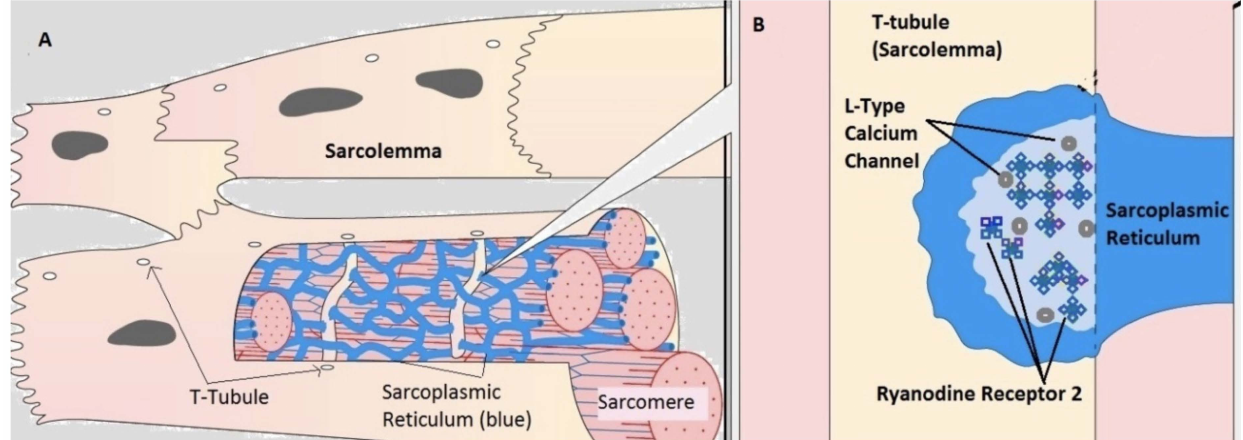
Figure 1. Cardiac myocyte structure. In the cardiac myocyte ( A ), CICR occurs at a specialized sub-domain called a dyad ( B ). The array of L-type calcium channels (LCC) on the T-tubule membrane and ryanodine receptor 2 (RYR2) channels on the sarcoplasmic reticulum (SR) make up the